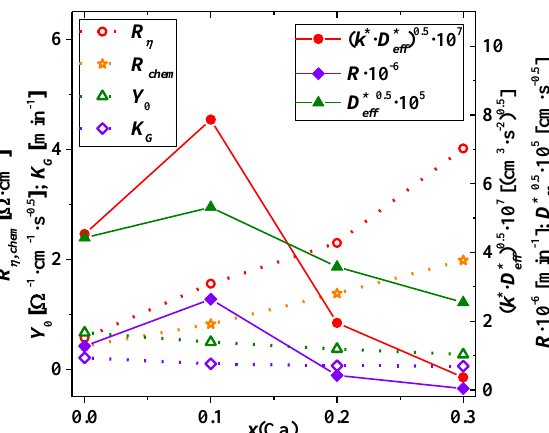
Figure 10. Correlation between the EIS data such as polarization R η , Gerischer R G resistance, Gerischer admittance Y 0 , Gerischer time constant K G and the isotopic exchange kinetic parameters k * D eff* , oxygen heteroexchange rate R , tracer diffusion coefficient D eff* . for the La 2−x Ca x NiO 4+δ series at 700 °C in air.